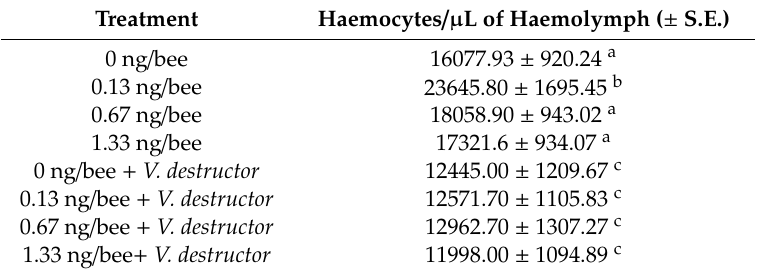
Table 3. Mean number of haemocytes per µ L of haemolymph ( ± S.E.) of newly emerged bees exposed to sublethal doses of clothianidin (ng / bee) and / or V. destructor during the larval stage. Treatment Haemocytes / µ L of Haemolymph ( ± S.E.)